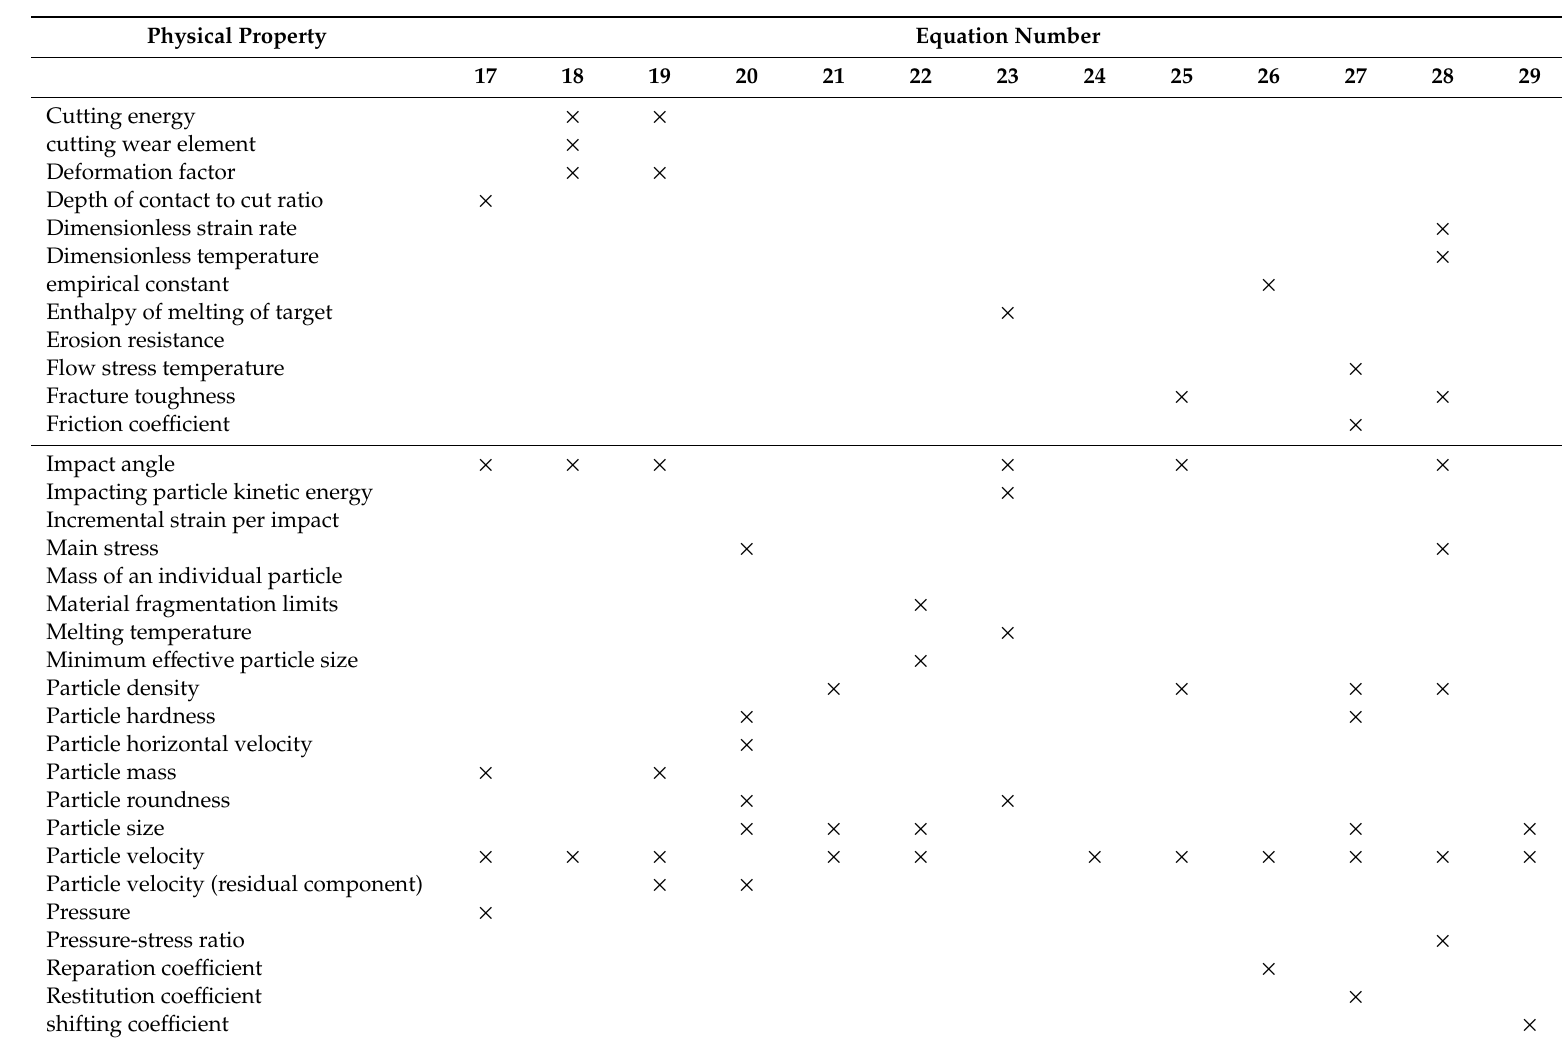
Table 4. Physical parameters used in erosion models